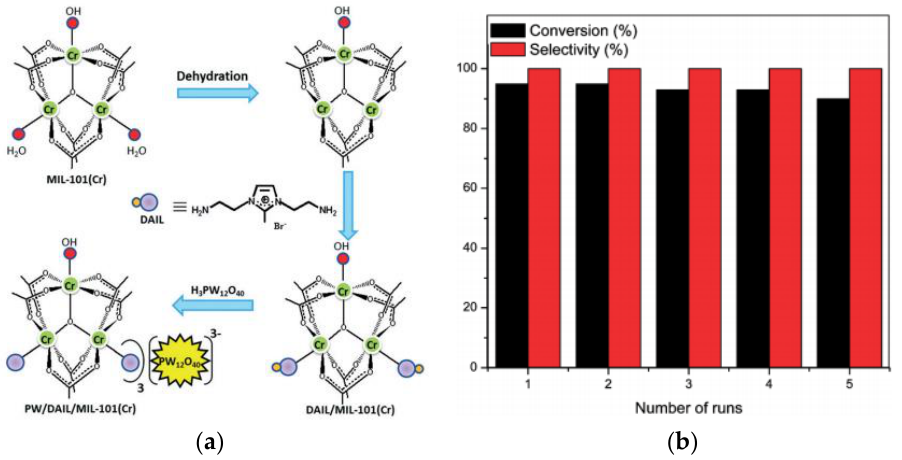
Figure 2. ( a ) Schematic illustration of the preparation of PW/dual amino-functionalized ionic liquid (DAIL)/MIL-101(Cr); ( b ) recyclability of the PW/DAIL/MIL-101(Cr) catalyst. Reprinted with (DAIL) / MIL-101(Cr); ( b ) recyclability of the PW / DAIL / MIL-101(Cr) catalyst. Reprinted with permission permission from [34]. Copyright (2017), Royal Society of Chemistry. from [34]. Copyright (2017), Royal Society of